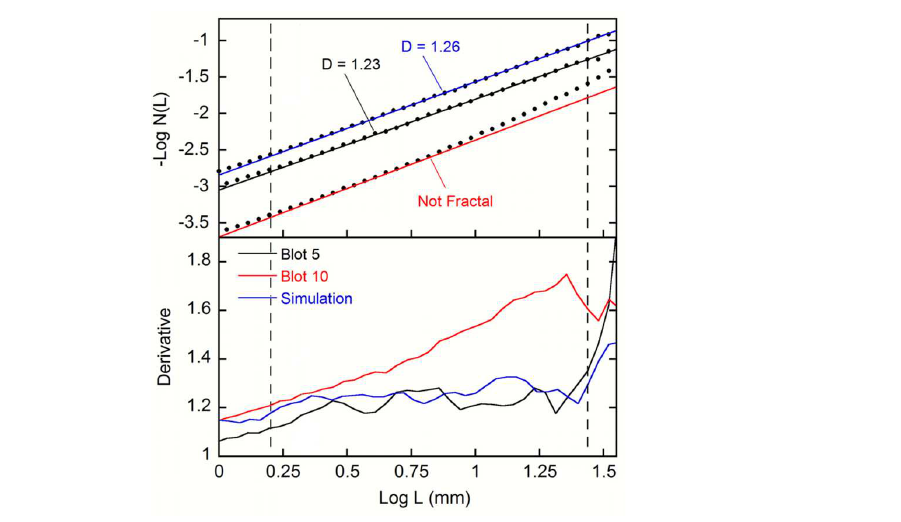
Fig 3. Top three traces:Box-counting analyses applied to Rorschach Blot Five (black), Rorschach Blot Ten (red), and a computer-generated fractal boundary (blue). Bottom three traces: the derivatives of the three scalingplots (see text for